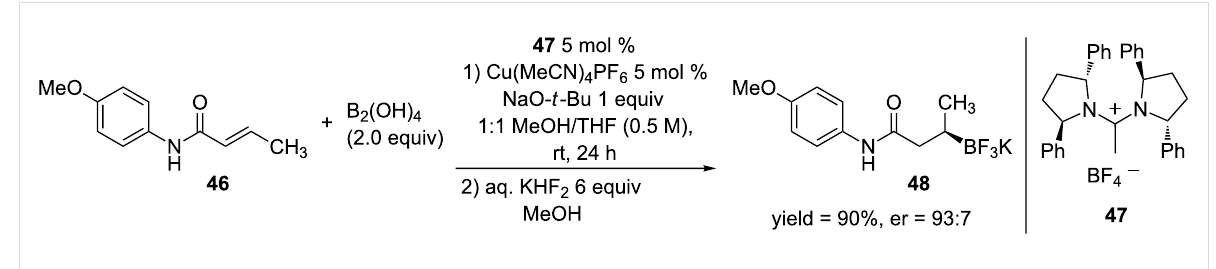
Scheme 11: Asymmetric copper-catalyzed 1,4-borylation of an α , β -unsaturated amide.